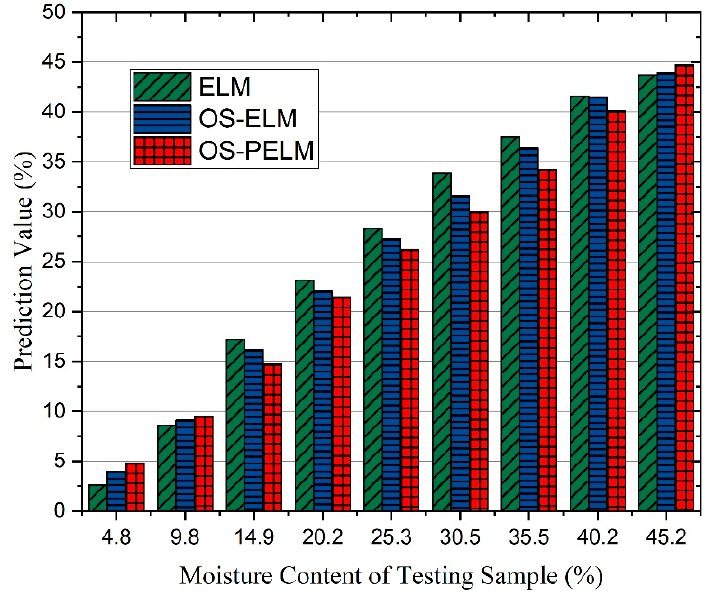
Figure 11. The prediction results of the OS-PELM algorithm and two comparison algorithms on nine sample woods with different MC levels.